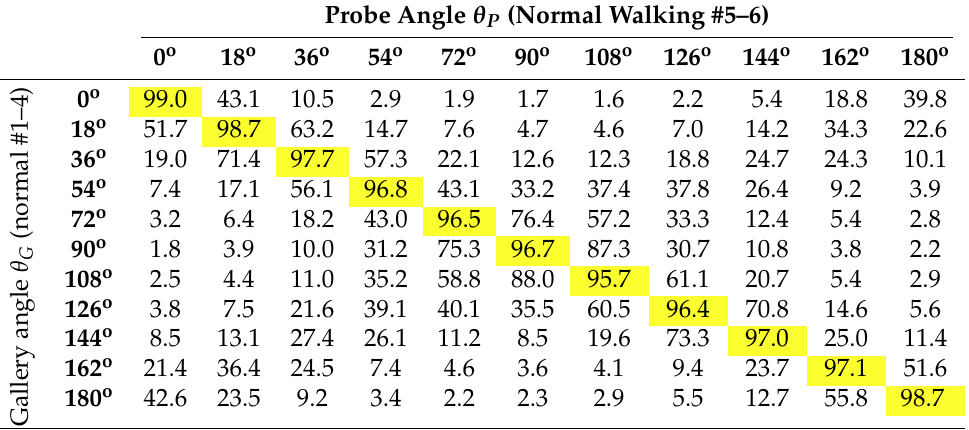
Table 4. Evaluation results using rule 1 (24 classes for the training group, 100 classes for the testing group, which is divided into gallery subset 1–4 and probe subset 5–6).